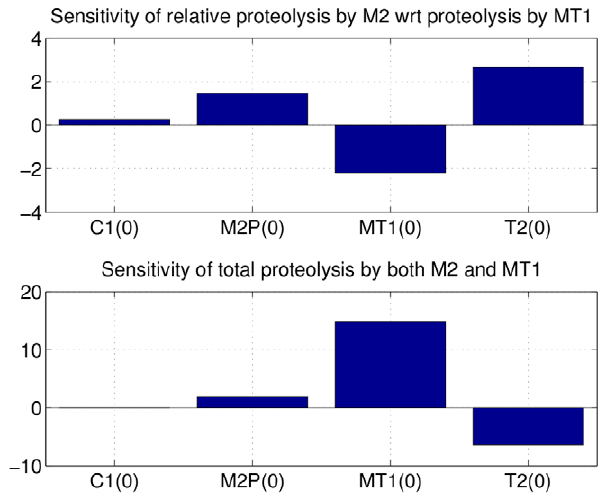
Figure 8. Global sensitivity analysis of proteolysis with respect to initial concentrations after 12 h. These histograms were obtained by applying the global sensitivity formula (8) for N=1000 samples in the parameter set P glob where p i is replaced by the initial concentrations C 1 (0) , M P (0) , MT 1 (0) and T 2 (0) . The top histogram 2 indicate that TIMP2 has globally an activation role for proteolysis controlled by M2-MMP, but a globally negative influence on the total degradation of collagen (bottom histograms), while MT 1 has a globally positive influence on it.